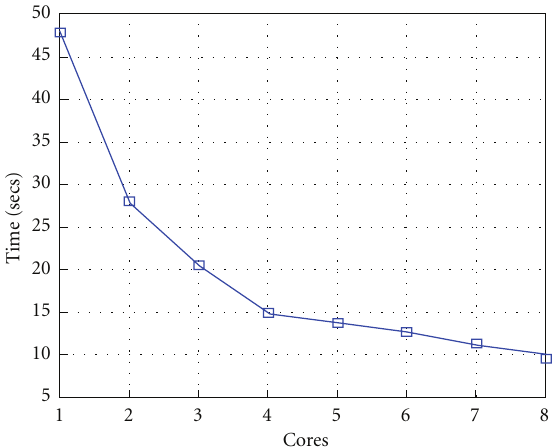
Figure 22: Test 2: Algorithm SI: Speedup. Δ τ I = 0 . 16.